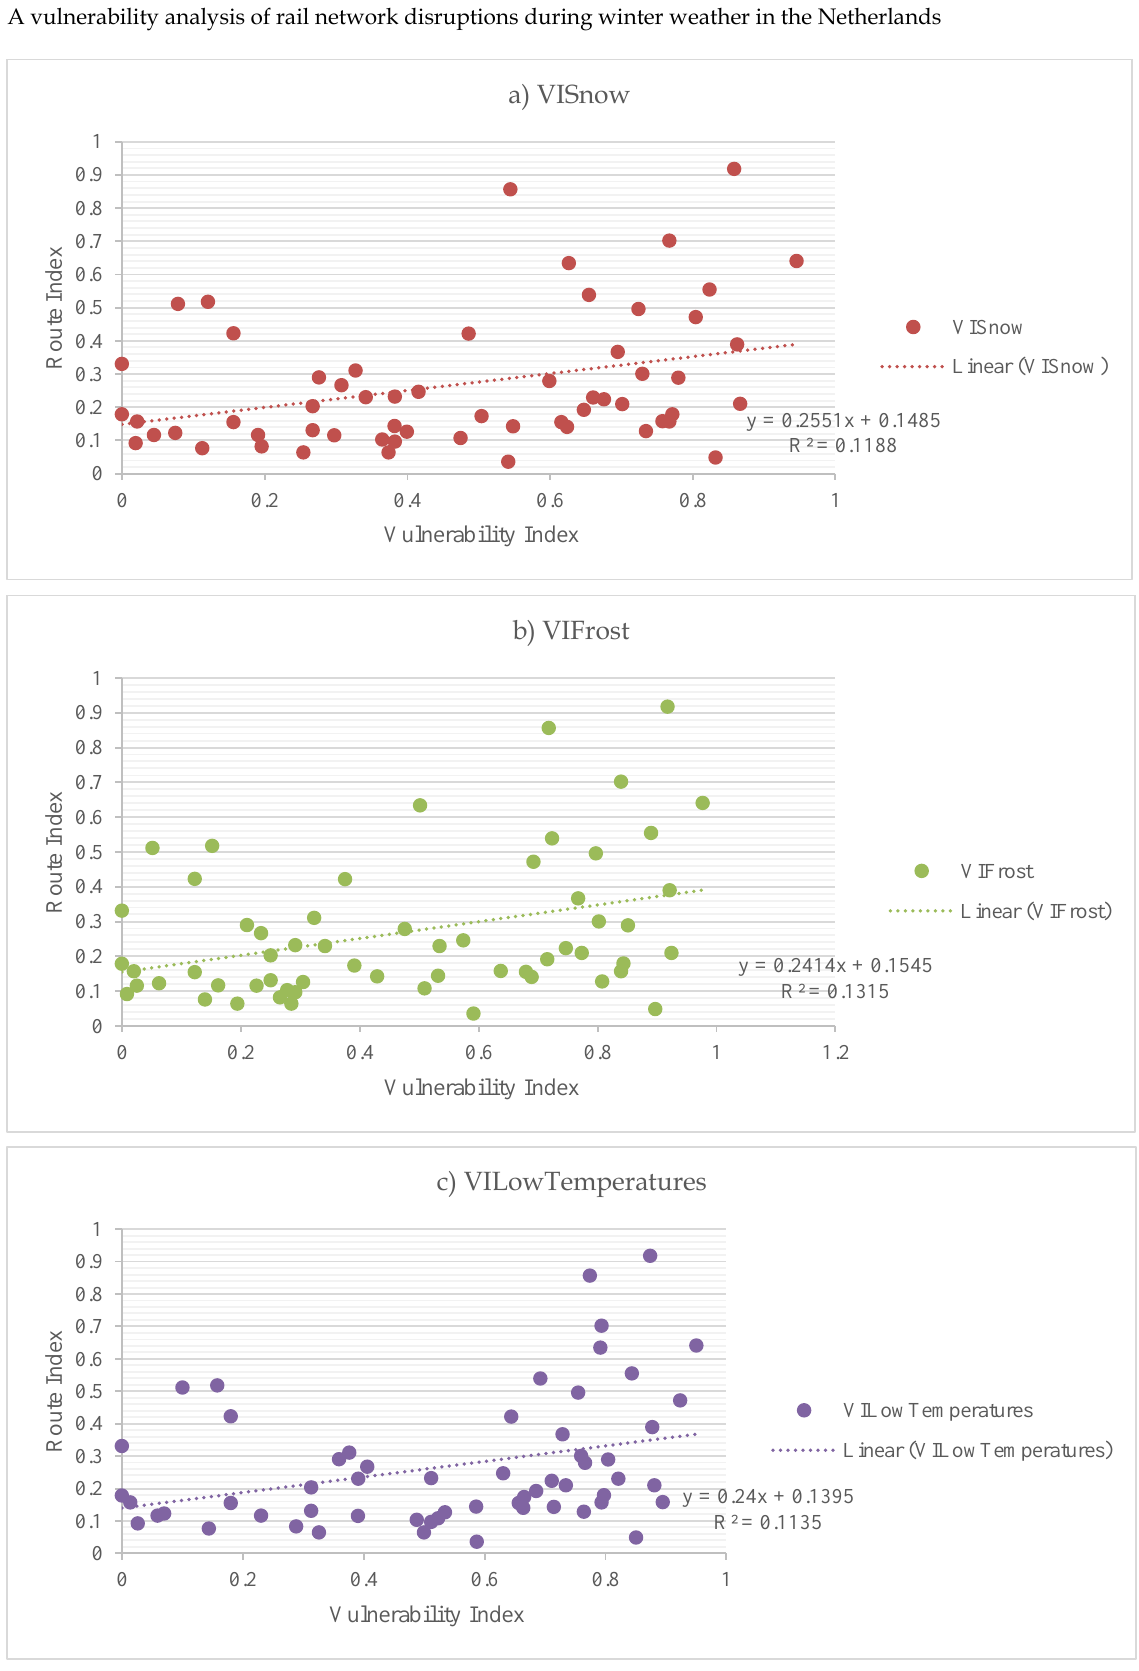
Figure 11 Vulnerability Index by station and route index per weather